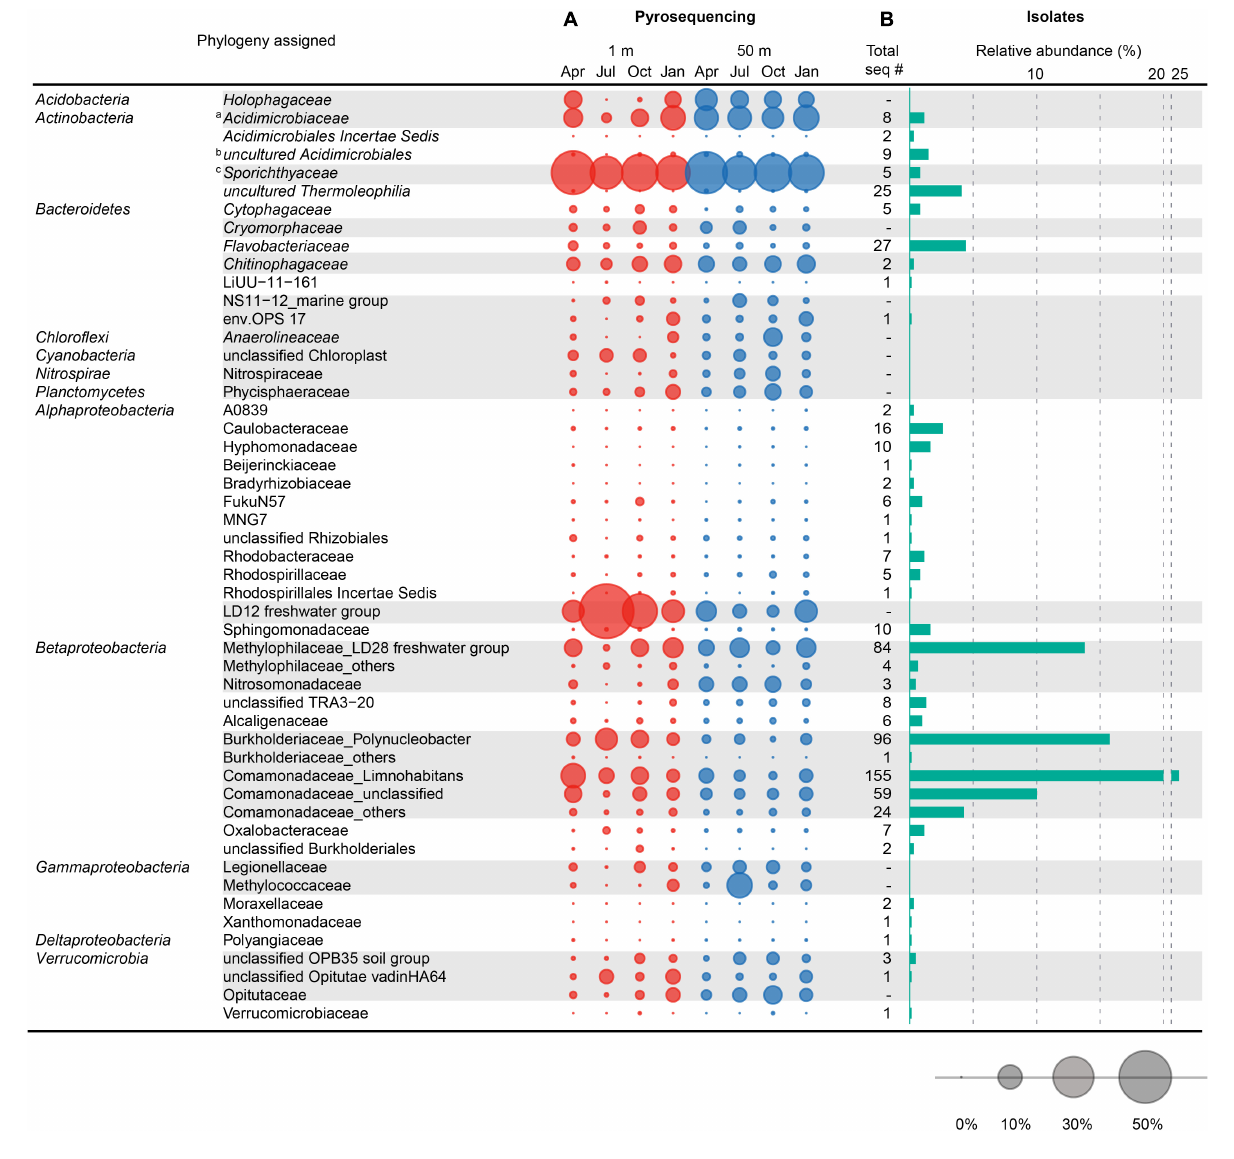
FIGURE 5 | Comparison between the family-level taxonomic composition of the bacterial community structure obtained by pyrosequencing and the composition of the bacterial isolates cultured by HTC. (A) Seasonal variation of the bacterial community structure at the family level observed at 1 and 50 m depths in Lake Soyang, as characterized by 16S rRNA gene pyrosequencing. (B) Phylogenetic composition and abundance of 605 axenic HTC isolates at the family level. The bubbles represent the percentage of pyrotags of each taxonomic group in each sample. Taxonomic groups with gray shades represent major phylogenetic groups that occupied > 1% of the total bacterial community in eight samples or > 2.5% of the bacterial community in each sample. Taxonomic classification of 16S rRNA gene sequences of HTC isolates and pyrotags was determined using the Mothur software based on the SILVA taxonomy database. a Contains the acIV-A, -B, and -C lineages. b Contains acIV-D lineage. c Contains the acI